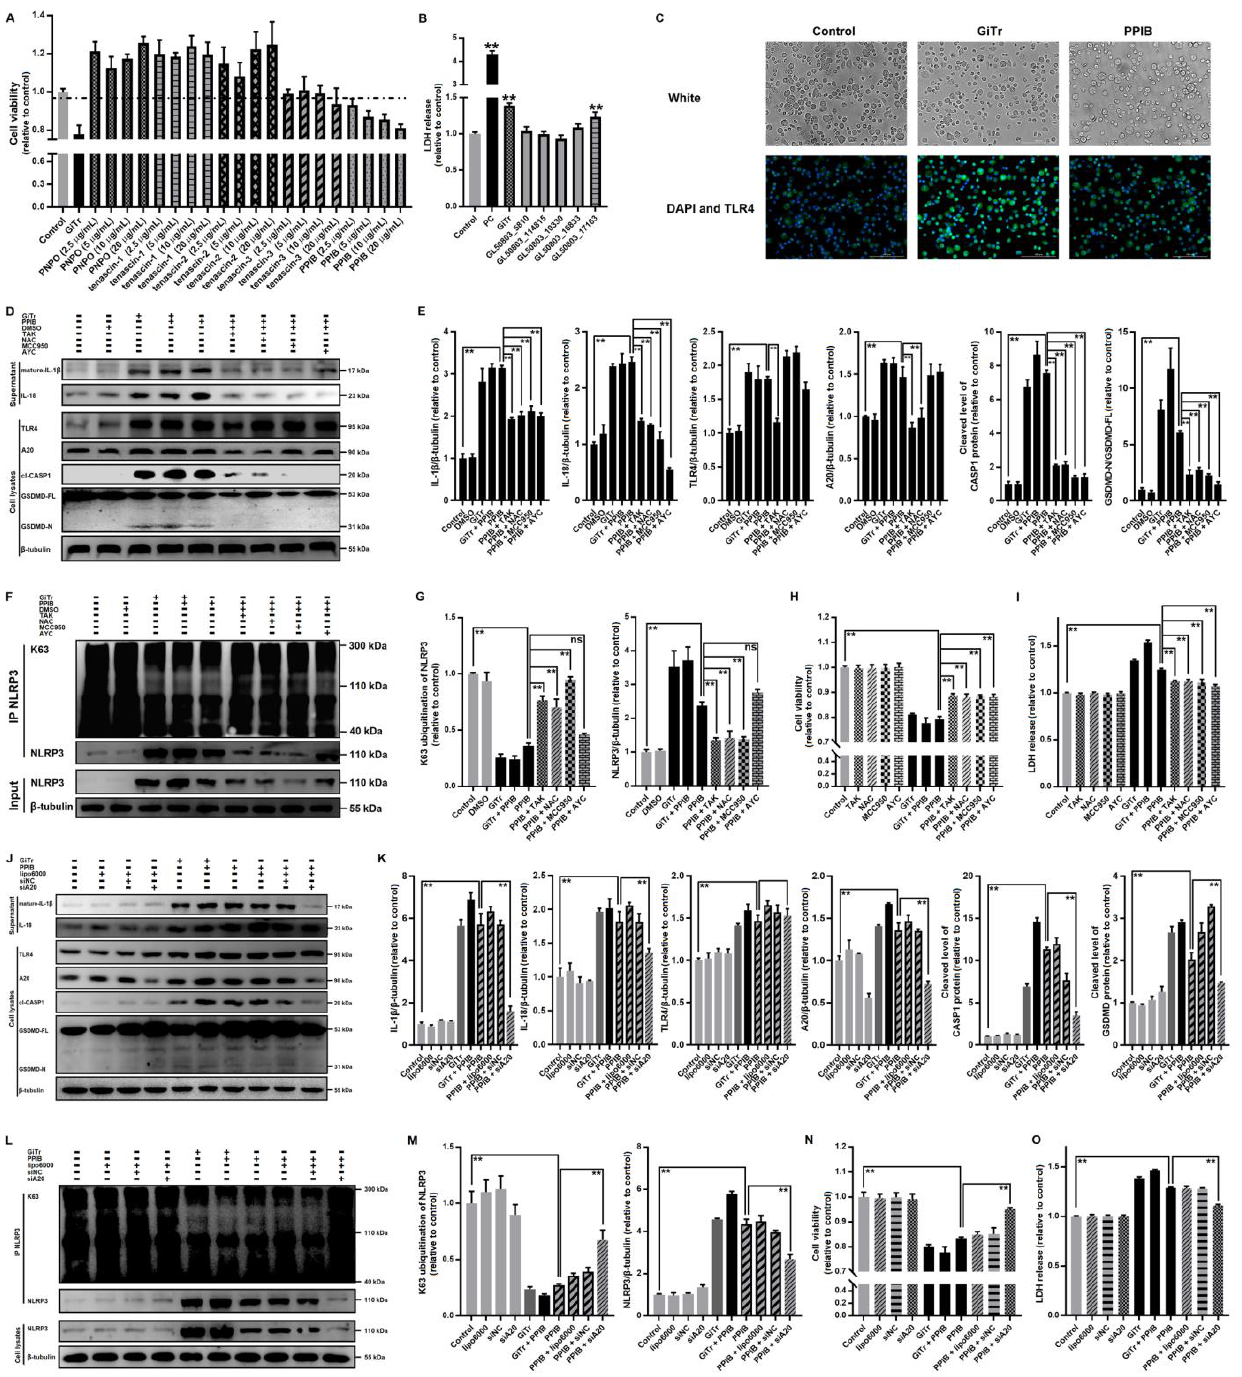
Figure 6. Giardia -secreted PPIB independently induced macrophage pyroptosis. PMs were treated for 12 h with Giardia trophozoites at a ratio of 10 parasites/cell and with the purified recombinant proteins at the indicated concentrations. ( A ) Cell viability among groups was assessed. ( C – O ) A protein concentration of 20 μg/mL was used for stimulation. ( B ) The levels of LDH release were assessed among groups. ( C ) TLR4 activation was assessed by immunofluorescence staining (scale bar = 100 μm). ( D – I ) The inhibitor TAK/NAC/MCC950/AYC was applied for 2 h before treatment. ( D – G ) Western blot and co-IP analyses indicated that PPIB triggered macrophage pyroptosis by a similar mechanism as parasites. ( H , I ) Cell viability and LDH release were affected by the same signaling. ( J – O ) The siA20 and scrambled siRNA were applied for 48 h before treatment. ( J – M ) Western blot and co-IP analyses indicated that K63 deubiquitination of NLRP3 by A20 was essential for PPIB/ Giardia -induced macrophage pyroptosis. ( N , O ) Cell viability and LDH release were also affected by A20 inhibition. All experiments were repeated at least three times. ( A , B , E , G – I , K , M – O ) Values are expressed as the